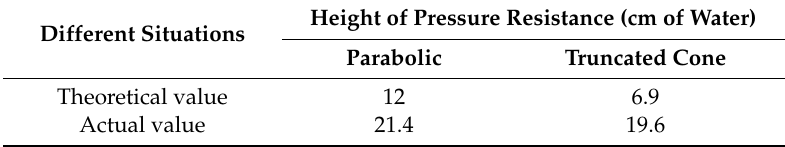
Table 2. The values of the height of pressure resistance under different